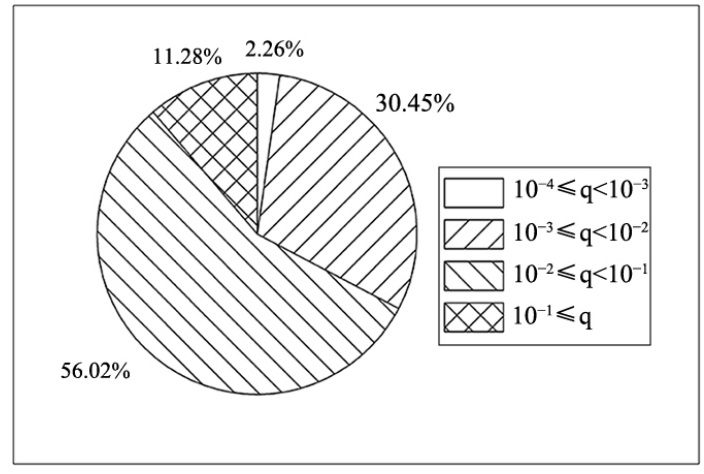
Figure 2. TIWTE dataset distribution.